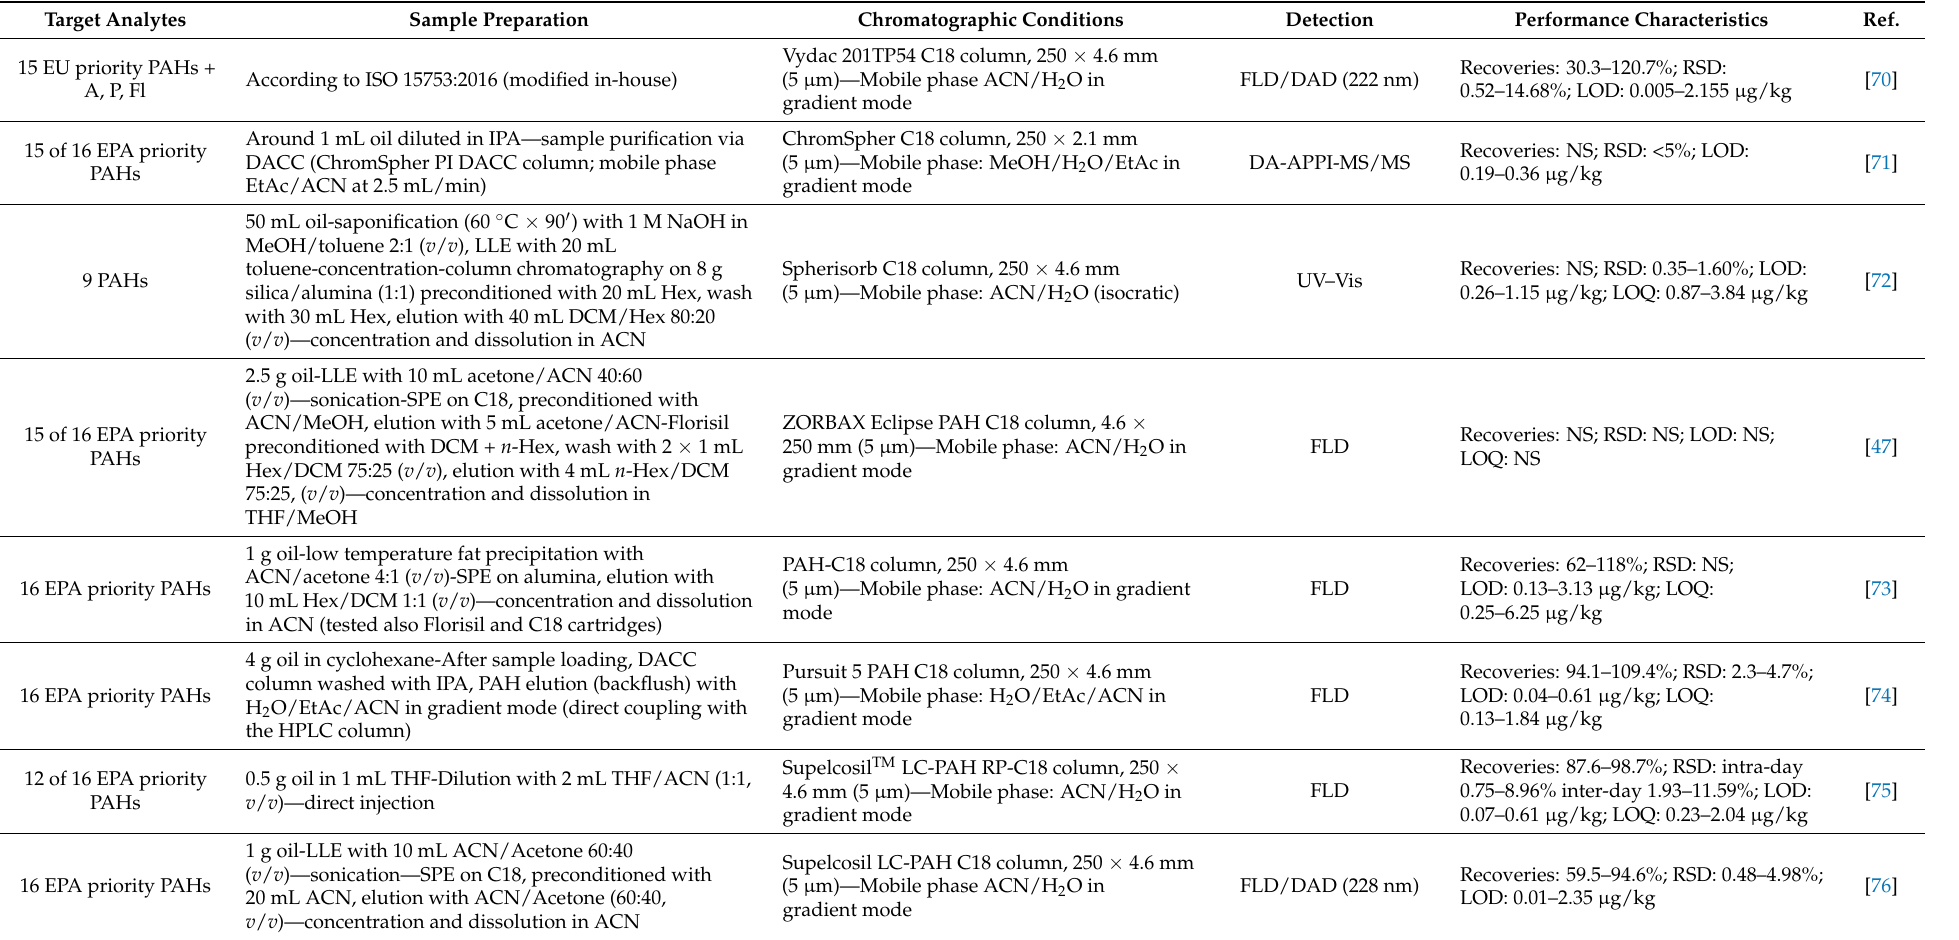
Table 3. HPLC methods used for PAH determination in olive oils